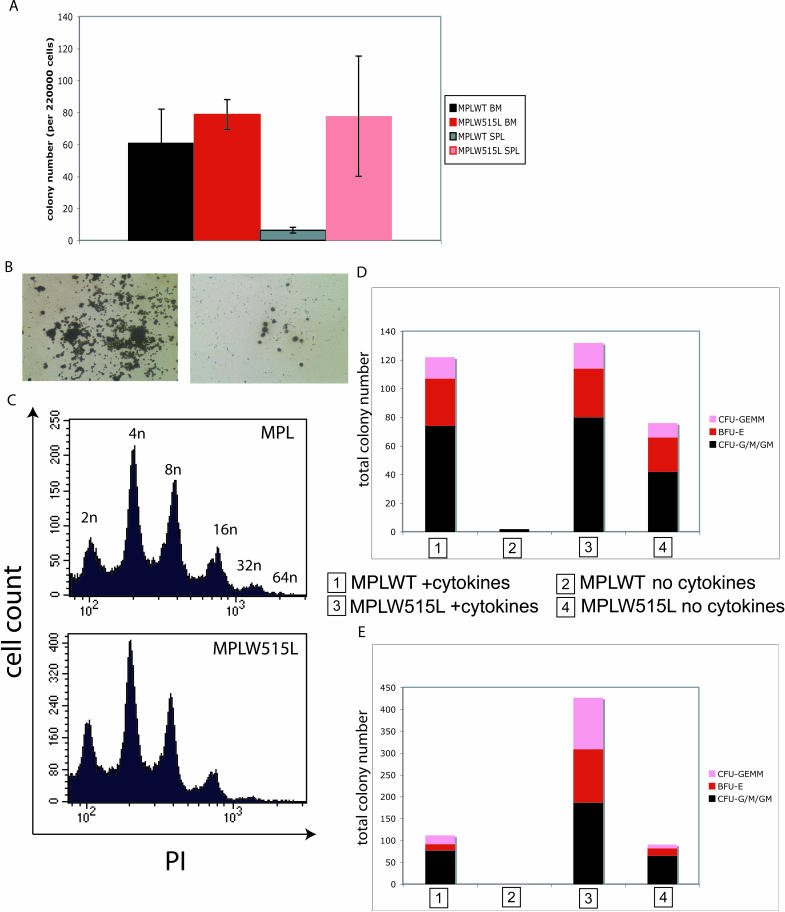
MPLW515L Increases the Number of Megakaryocyte and Myeloid Colonies in Spleen, without Affecting Megakaryocyte Ploidy, and Causes Cytokine-Independent Myeloid Colony Growth(A) Megakaryocyte colony–forming assay in the presence of TPO, IL3, IL11, and IL6 demonstrates similar numbers of megakaryocyte colonies obtained from MPLW515L-expressing bone marrow and an increase in the number of megakaryocyte colonies from spleen cells compared with MPLWT.(B) Acetylcholinesterase staining of megakaryocyte colonies derived from bone marrow demonstrates much larger colony size in MPLW515L as compared with MPLWT megakaryocyte colonies.(C) Megakaryocyte ploidy analysis shows the same distribution for MPLW515L-expressing cells and MPLWT-expressing cells.(D and E) Total myeloid colony formation from bone marrow cells (D) and spleen cells (E) demonstrates cytokine-independent colony formation in MPLW515L bone marrow and spleen. There is no difference in colony distribution between MPLWT- and MPLW515L-expressing cells. Colony counts reflect only positively identifiable colonies, with thorough megakaryocyte colony analysis done in MegaCult assay (
Figure 6A), and thus are excluded from methylcellulose colony analysis. Colony numbers represent a total of three representative mice per group, in duplicate.